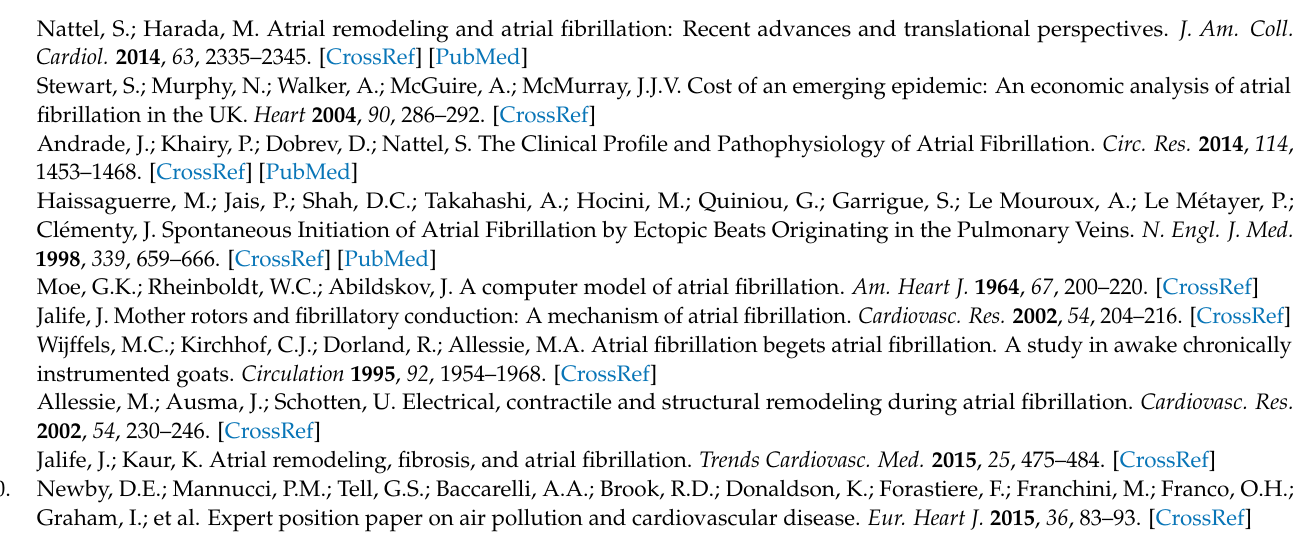
figuration at low density; Video S3: fibroblasts configuration at high density, Video S4: